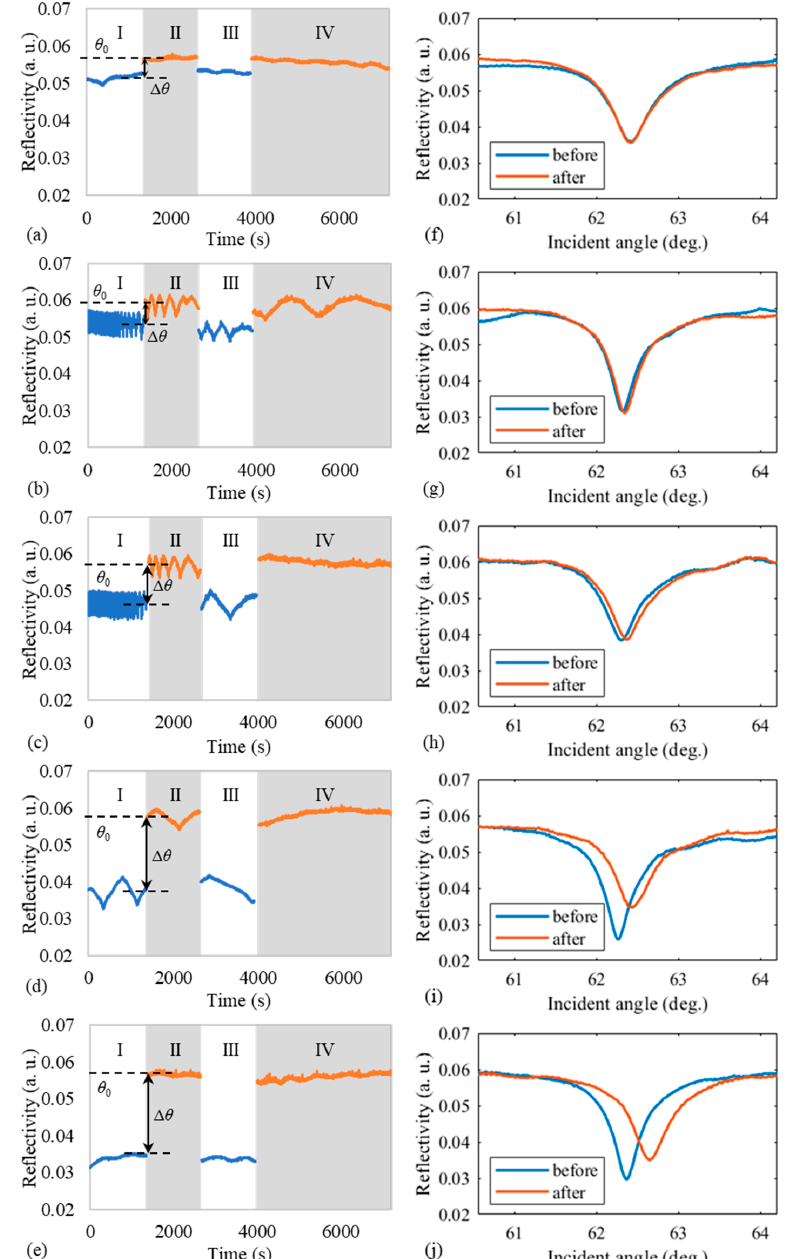
Figure 4. ( a – e ) PATR results and ( f – j ) ATR curve before and after the whole experiment process, with different intensities of the pump laser: ( a , f ) 0.3, ( b , g ) 0.6, ( c , h ) 1.0, ( d , i ) 3.0, and ( e , j ) 5.0 mW. The time intervals II and IV, when the pump laser did not irradiate, are marked with gray backgrounds.